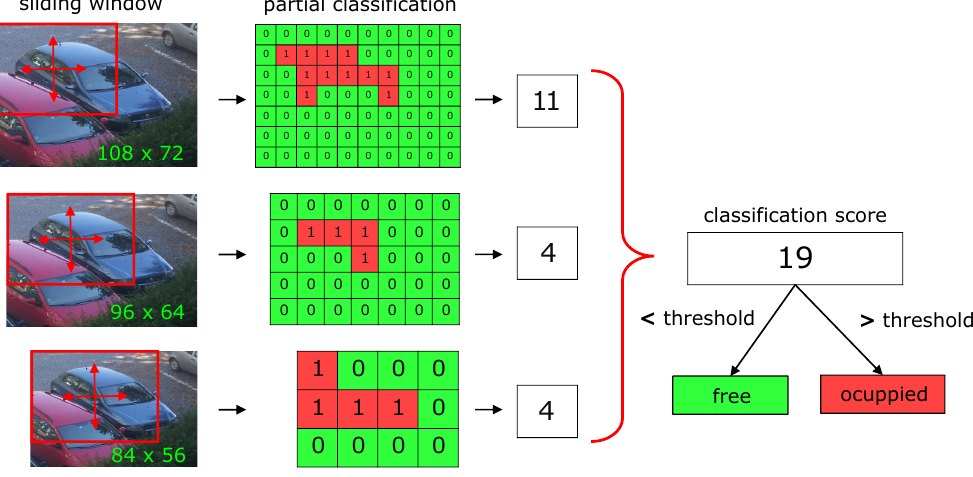
Figure 5. Classification of the single parking